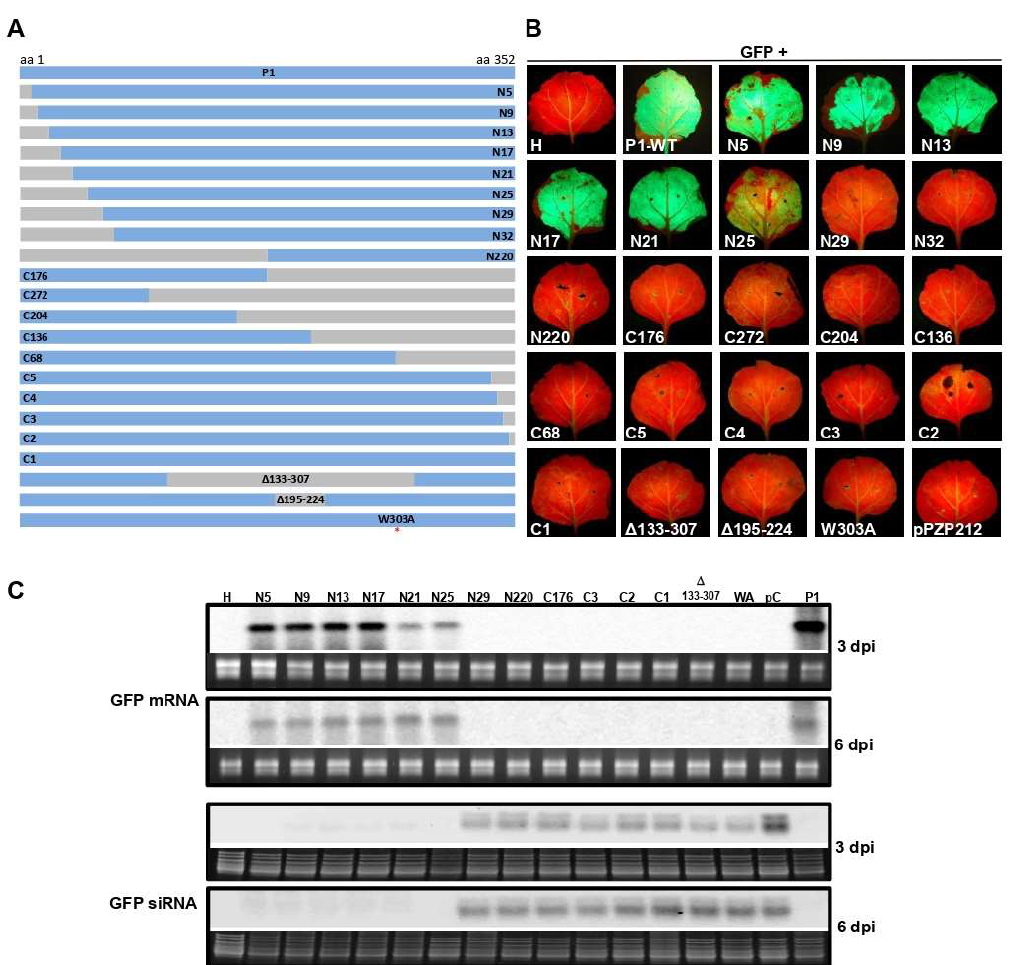
Figure 1. Analyses of wheat streak mosaic virus (WSMV) P1 for RNA silencing suppression activity. ( A ) Map of deletion and site-directed mutants of WSMV P1 engineered under a CaMV 35S promoter in pPZP212 for agroinfiltration into Nicotiana benthamiana leaves for GFP reporter assay. ( B ) Green fluorescent images of N. benthamiana leaves agroinfiltrated with indicated constructs along with pPZP212-35S:GFP as a reporter at 6 days postagroinfiltration (dpa). “H” indicates uninfiltrated healthy leaf; pPZP212 indicates agroinfiltration of pPZP212 along with pPZP212-35S:GFP (negative control). Note the loss of VSR activity of WSMV P1 with disrupted GW motif (W303A). ( C ) Northern blot hybridization of total RNA extracted from agroinfiltrated regions of selected constructs as indicated above the lanes. The top two and the bottom two panels show accumulation of GFP mRNA and siRNAs at 3 and 6 dpa, respectively. Ethidium bromide stained gel images shown below the Northern blots of GFP mRNA and GFP siRNAs are rRNA and low molecular weight RNAs, respectively, for the amount of RNA loaded per lane.